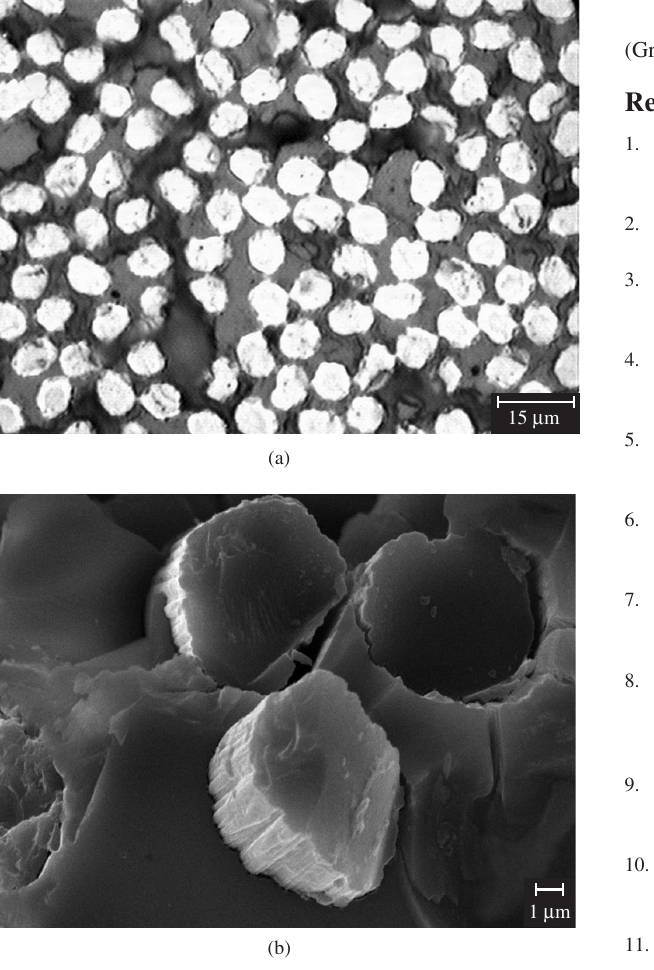
Figure 6. a) Optical; and b) SEM micrographs of the CMC obtained from MTES-derived PBS (B/Si =